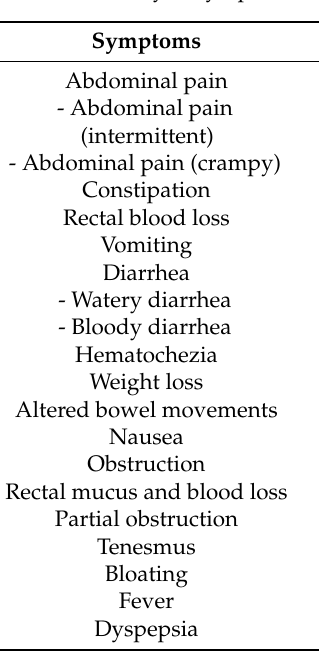
Table 1. Summary of symptoms described by the patients.